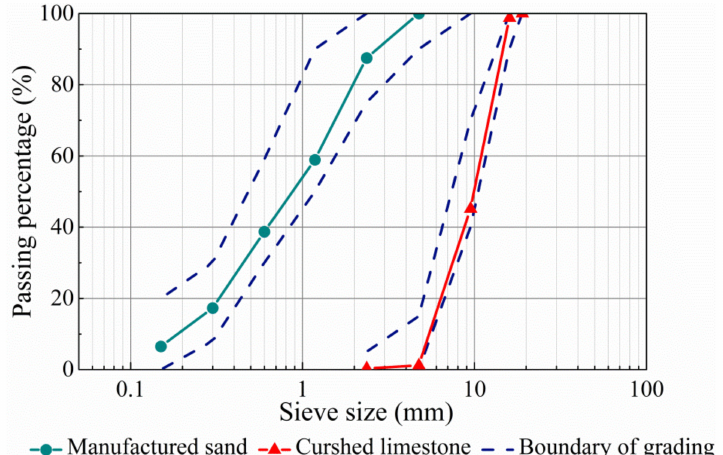
Figure 1. Grading of fine and coarse